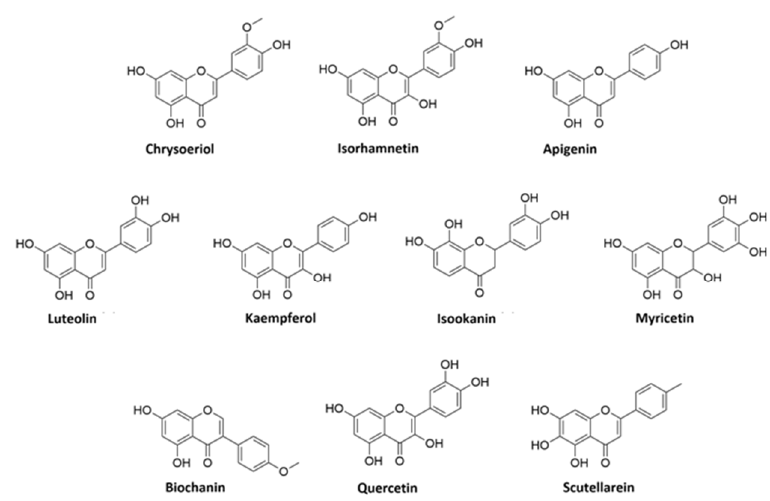
Figure 2. Structures of flavonoid aglycones identified in V. vinifera .